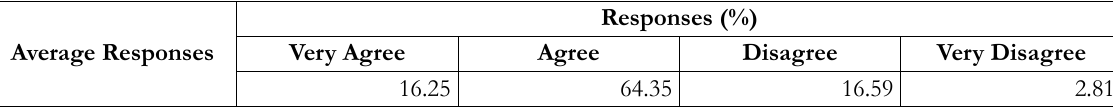
Table 9. Average student responses in the experimental class regarding learning activities that have been carried